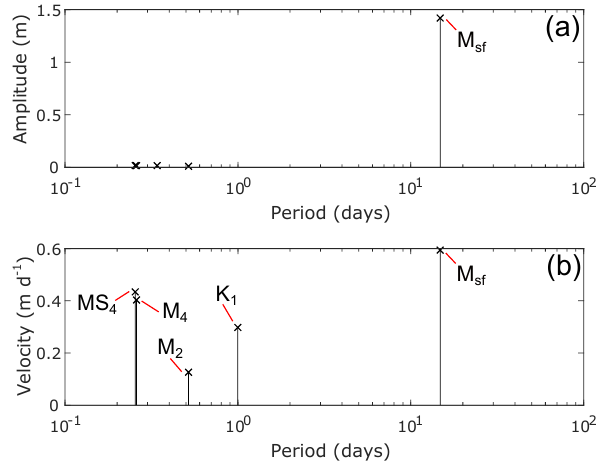
Figure 7. Tidal analysis of horizontal displacement (a) and veloc- ity (b) from the full-Stokes model, taken at the medial line, 100km downstream of the GL. Notable tidal constituents are labelled with their respective